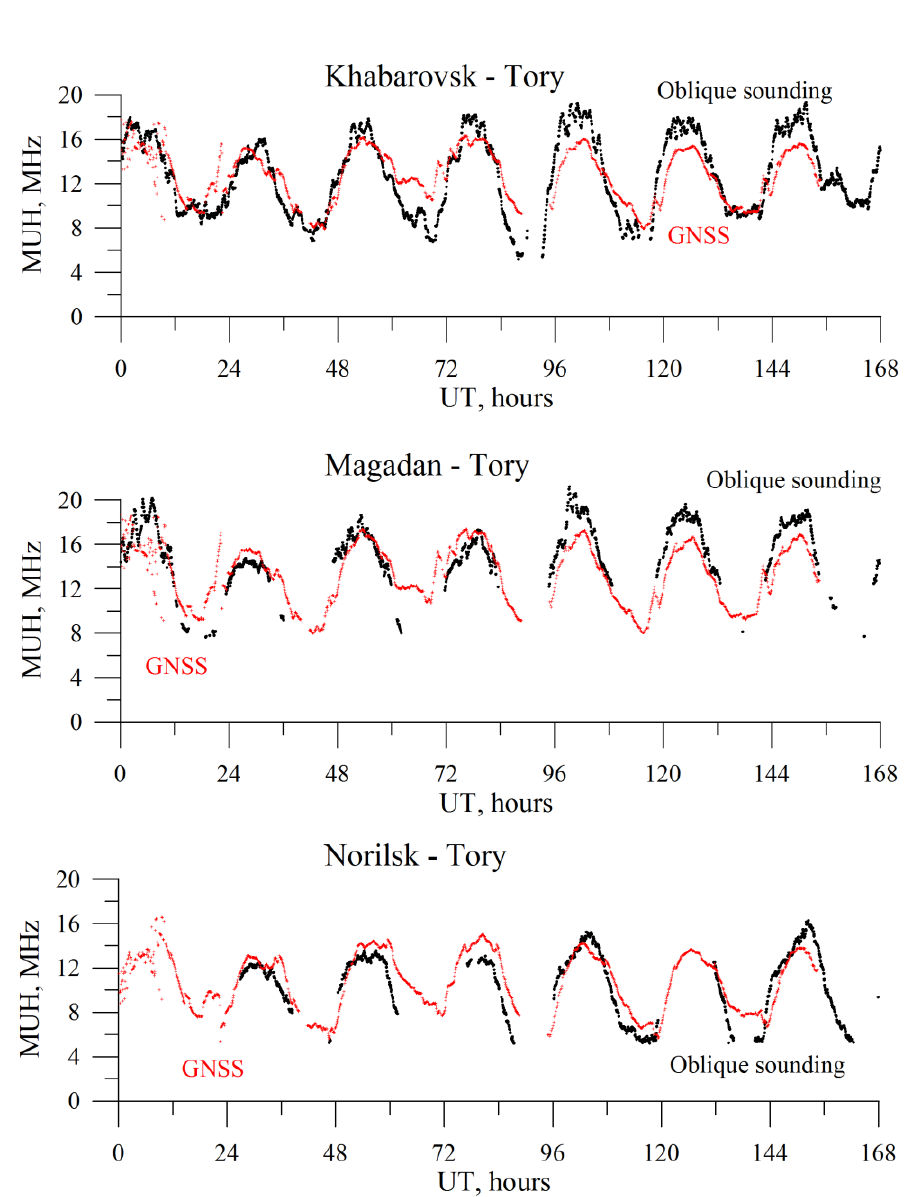
Figure 16. Maximum usable frequency at the Khabarovsk – Tory, Magadan – Tory, and Norilsk – Tory paths. Black dots refer to the data from the manual scaled ionograms of oblique sounding, gray dots present the estimates obtained based on the TEC from GNSS. Table 1. Errors of MUH estimates for different radio